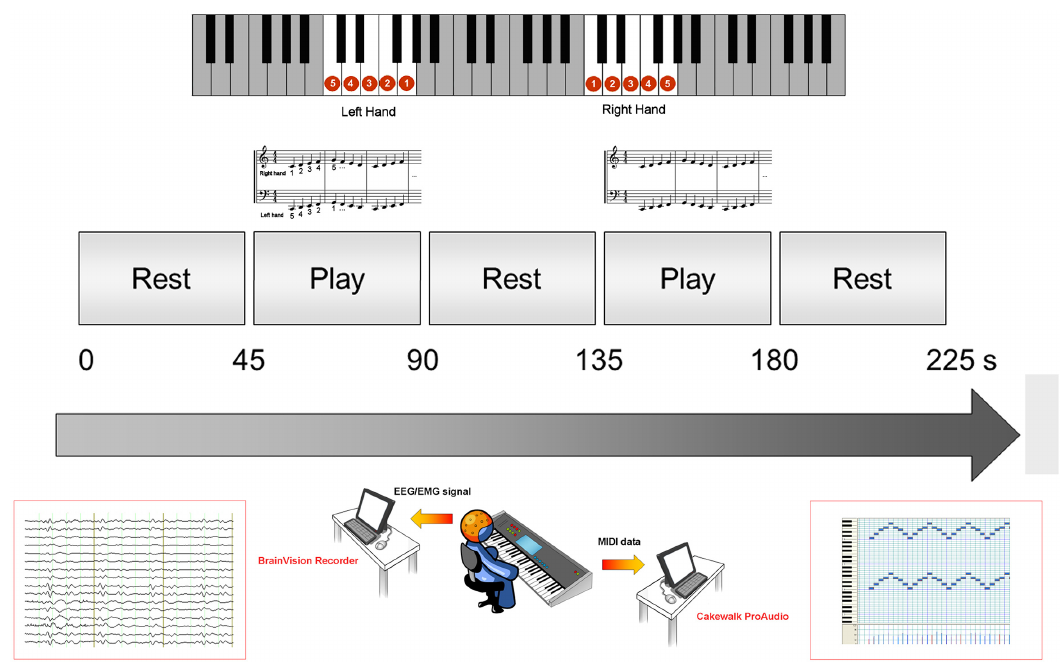
Fig 1. Experimental setup. EEG and EMG recording during the musical motor task performed with an electronic keyboard. Top: the blocks of motor performance are represented in terms of keyboard fingering (presented to the subjects) and standard musical notation. Center: the timing of the complete sequence is displayed. EEG and EMG signals were acquired with a PC connected to a BrainAmp system (bottom left) while MIDI data were recorded on another PC by means of a sequencing software (bottom